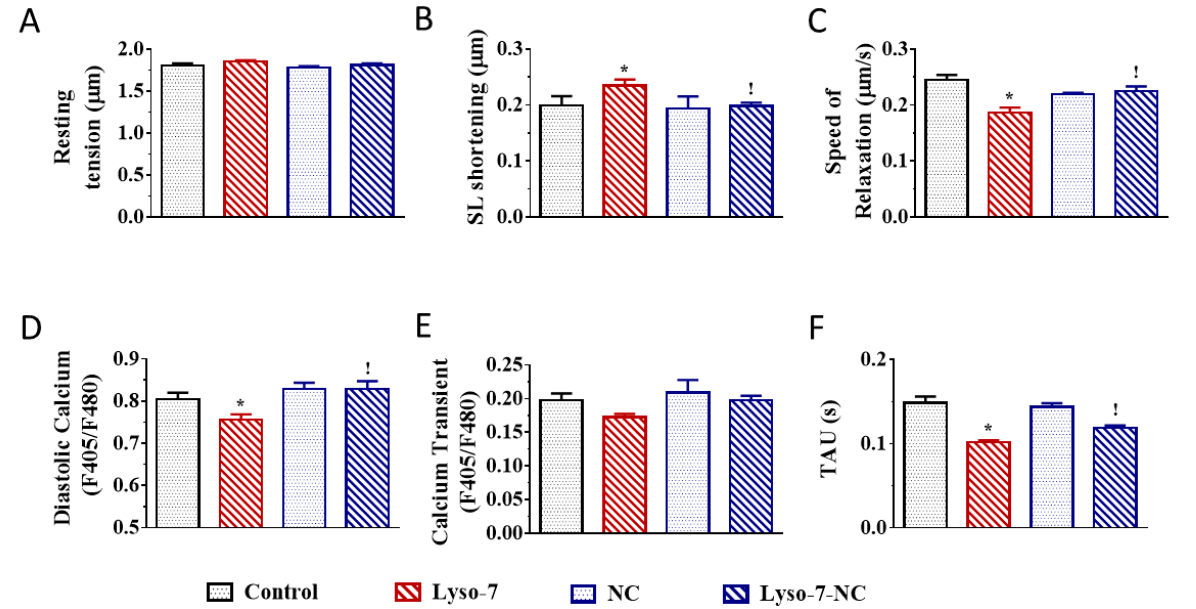
Figure 3. Effect of in vivo administration of Lyso-7 and Lyso-7-NC (1.6 mg/kg, once a day for seven days) on contraction (A–D) and Ca 2+ transient (E–H) of freshly isolated cardiomyocytes exposed in vitro to Isoproterenol (ISO, 10 nM). (A–C): averaged data of resting sarcomere length (SL), SL shortening and relaxation, respectively, and (D–F): averaged data of diastolic Ca 2+ , Ca 2+ transient and decay of Ca 2+ transient (Tau), respectively, all for the four experimental groups (Control, Lyso-7, NC, and Lyso-7-NC). ANOVA followed by Tukey post-test ( p < 0.05). * Lyso-7 vs. Control; ! Lyso-7-NC vs. Lyso-7. n = 4; n = 12–18.